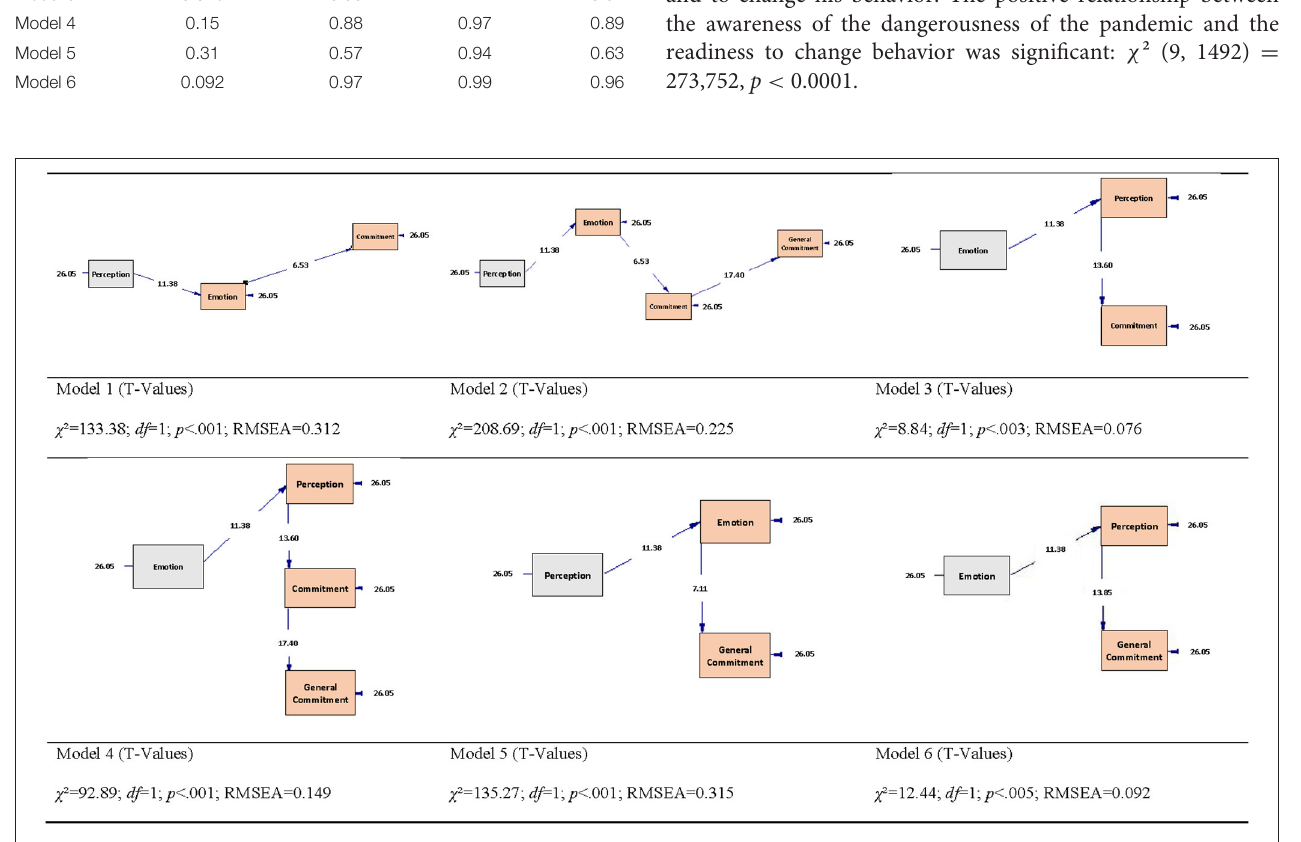
FIGURE 3 | Graph models of Path Analysis from 1 to